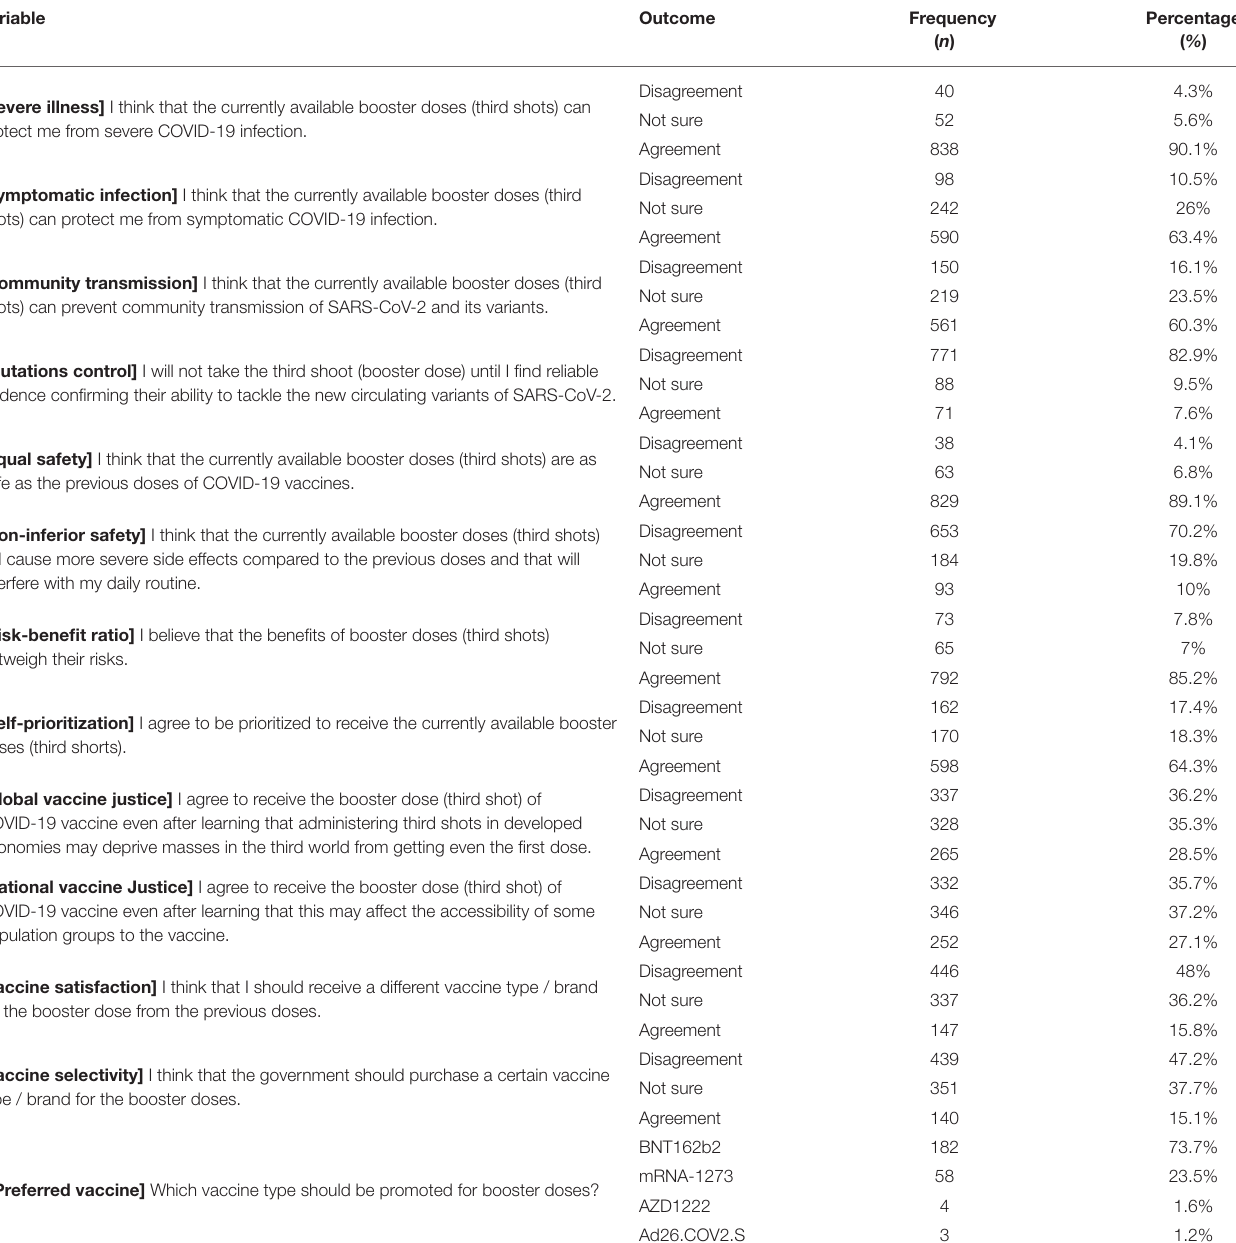
TABLE 4 | Psychosocial drivers of German university students and employees participating in the COVID-19 Vaccine Booster Hesitancy (VBH) Survey, december 2021 ( n = 930).